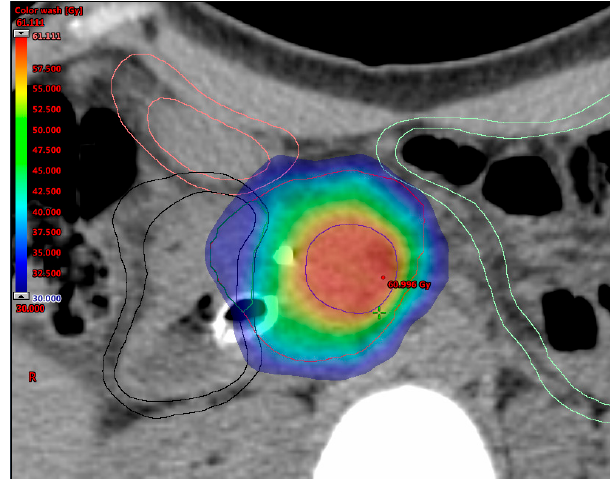
Figure 2. A dosimetric simulation study of the SBRT dose-escalation approach with Simultaneous Integrated Boost (SIB) and Simultaneous Integrated Protection (SIP) for LAPC. This example demonstrates excellent coverage of target volumes and respect of OARs (duodenum = black, bowel = light green, and stomach = pink). The PTV 40Gy (red) is created by adding 5 mm to the integrated gross target volume (iGTV) structure. The PTV 60Gy (blue) is generated to cover the tumor vessel interface (TVI) inside the iGTV, while the PTV 33Gy (dark green) corresponds to the overlap area between the PTV 40Gy and PRV OARs (luminal OARs + 3 mm).